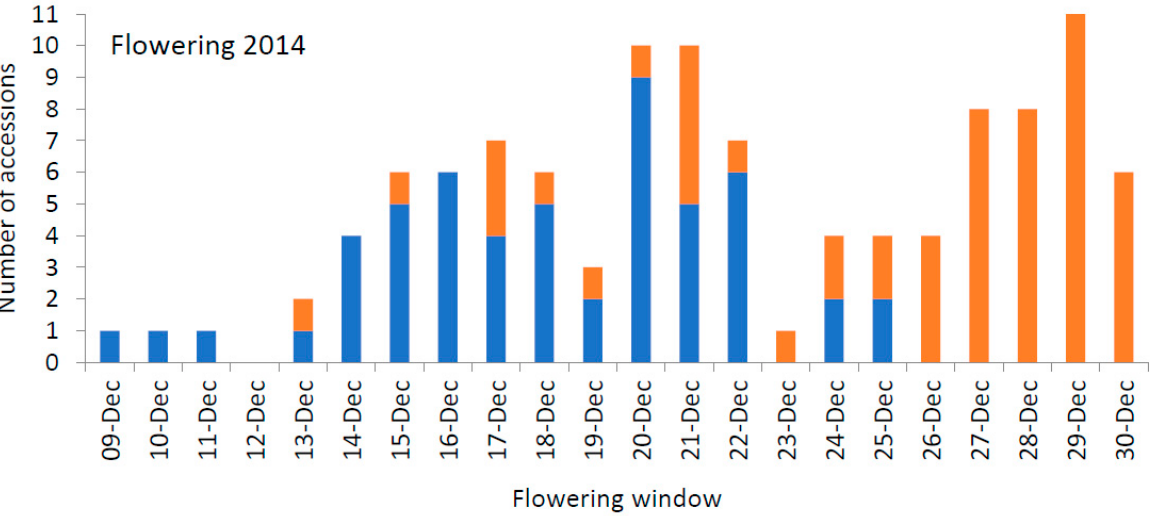
Figure 7. Histogram of time to 50% flowering for Chadian dry-season sorghum accessions sown early (blue bars) and late (red bars) in 2013 at the Youé research farms in Chad.